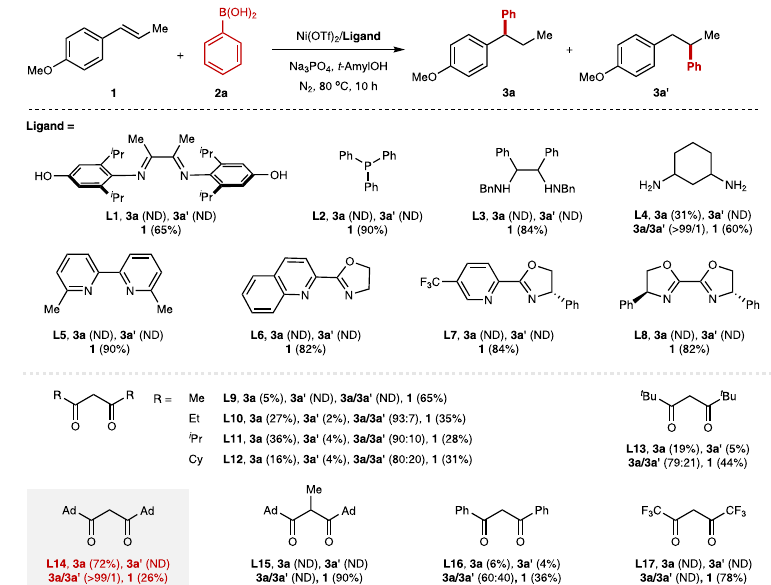
Fig. 2 | Ligand evaluation for Ni-catalyzed hydroarylation of internal alkenes. Reaction conditions: 1 (0.1mmol, 1.0 equiv), 2a (0.2mmol, 2.0 equiv), Ni(OTf) 2 (10mol%), Ligand (10mol%), Na 3 PO 4 (32.8mg, 2.0 equiv), t -AmylOH (0.5mL),